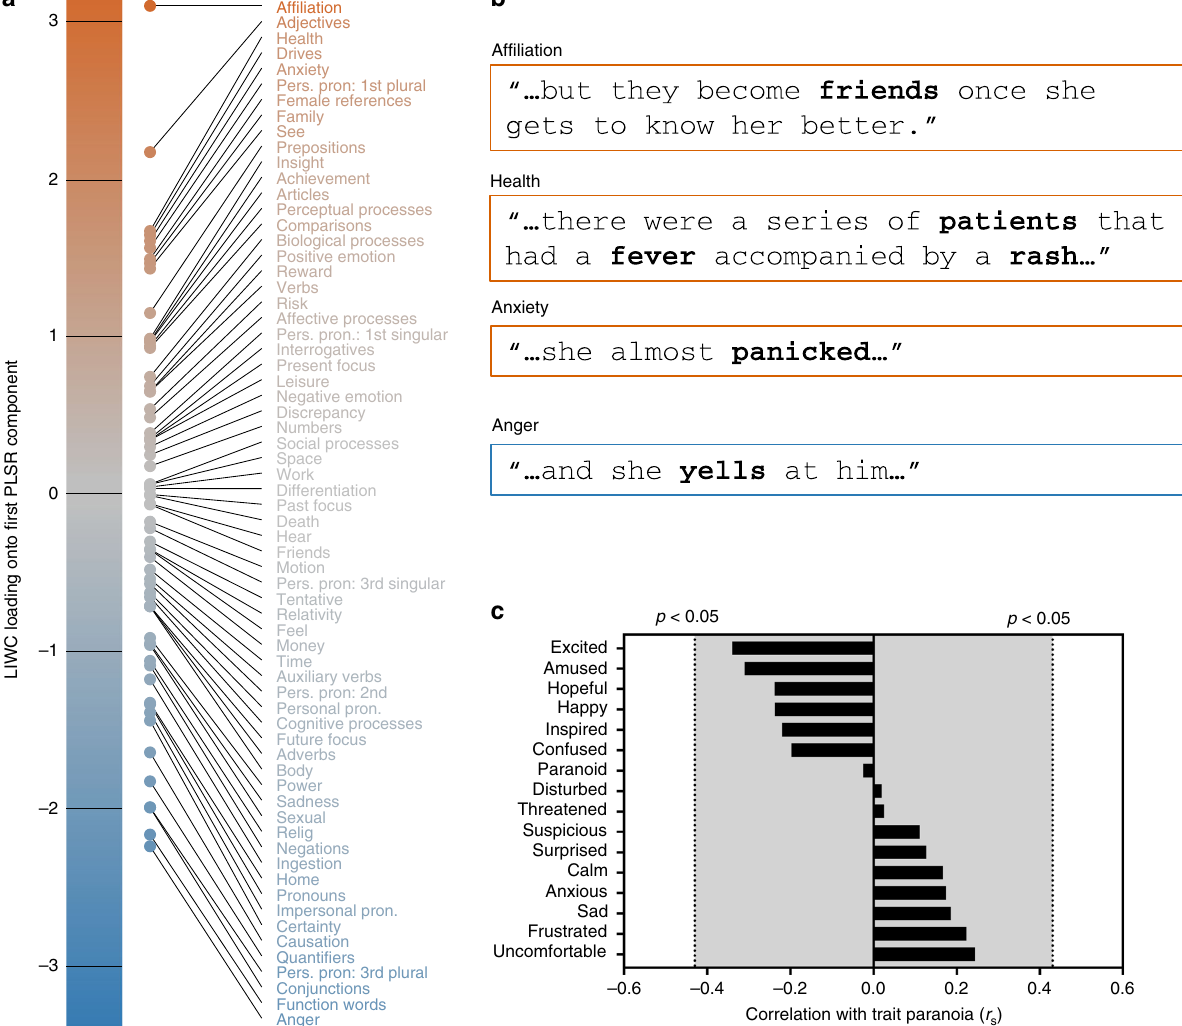
Fig. 6 Speech analysis reveals a signature of trait paranoia in behavioral response to the narrative. a Loadings of all semantic and syntactic categories for the fi rst component from a partial least squares regression relating features of speech during narrative recall to trait paranoia score, sorted by strength and direction of association with paranoia (those positively related to paranoia at top in orange; those inversely related at bottom in blue). b Example sentences from participant speech transcripts containing words falling into the three of the top positive categories (af fi liation, health, and anxiety) and one of the top negative categories (anger). c Rank correlations between participants ’ trait-level paranoia and their self-report measures of 16 emotions following the narrative (self-report was based on a Likert scale from 1 to 5). Dotted lines represent approximate threshold for a signi fi cant correlation at p < 0.05 (uncorrected). Gray-shaded area indicates non-signi fi